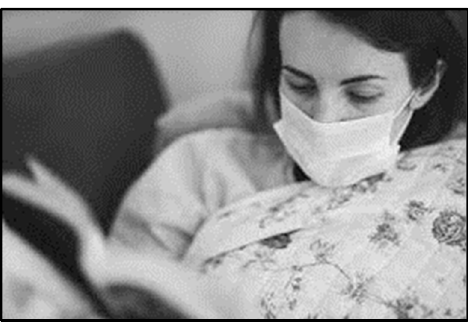
Figure A7. Monoclonal antibodies.